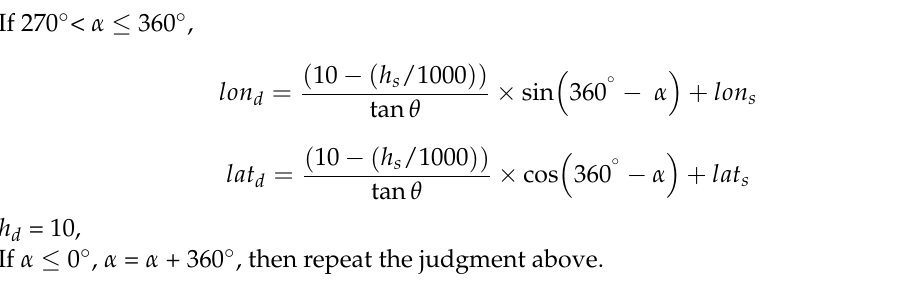
The surface perpendicular to the X-axis is defined as the X-axis profile, and the Y-axis and Z-axis profiles are named in the same way. Taking the intersection of the signal line and the Z-axis profile as an example, the red line represents the signal line in Figure 2, the red line represents the satellite position, and the blue origin represents the station position.